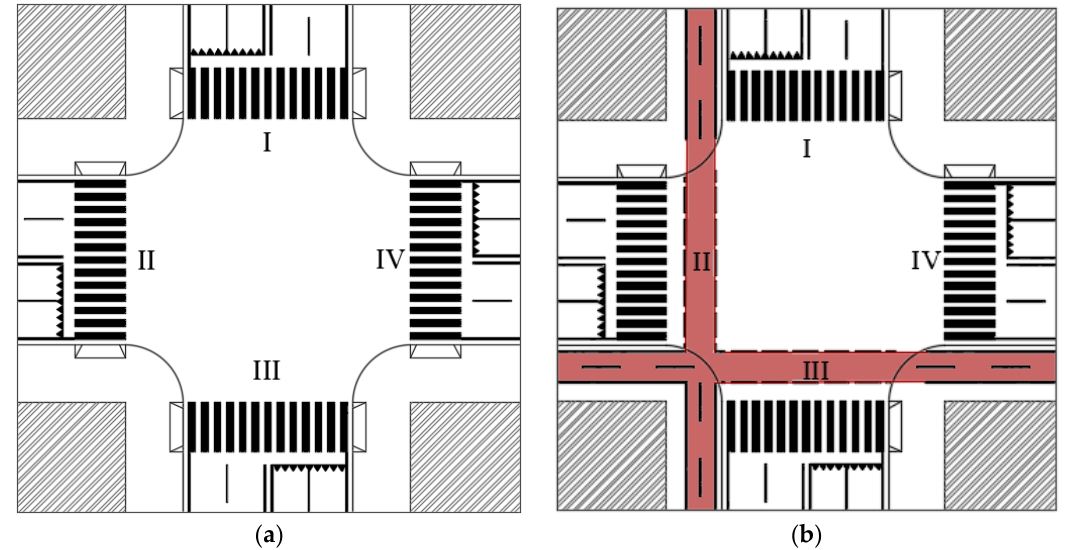
Figure 1. Study schemes: ( a ) four-leg junction without bike path; ( b ) four-leg junction with bike path.